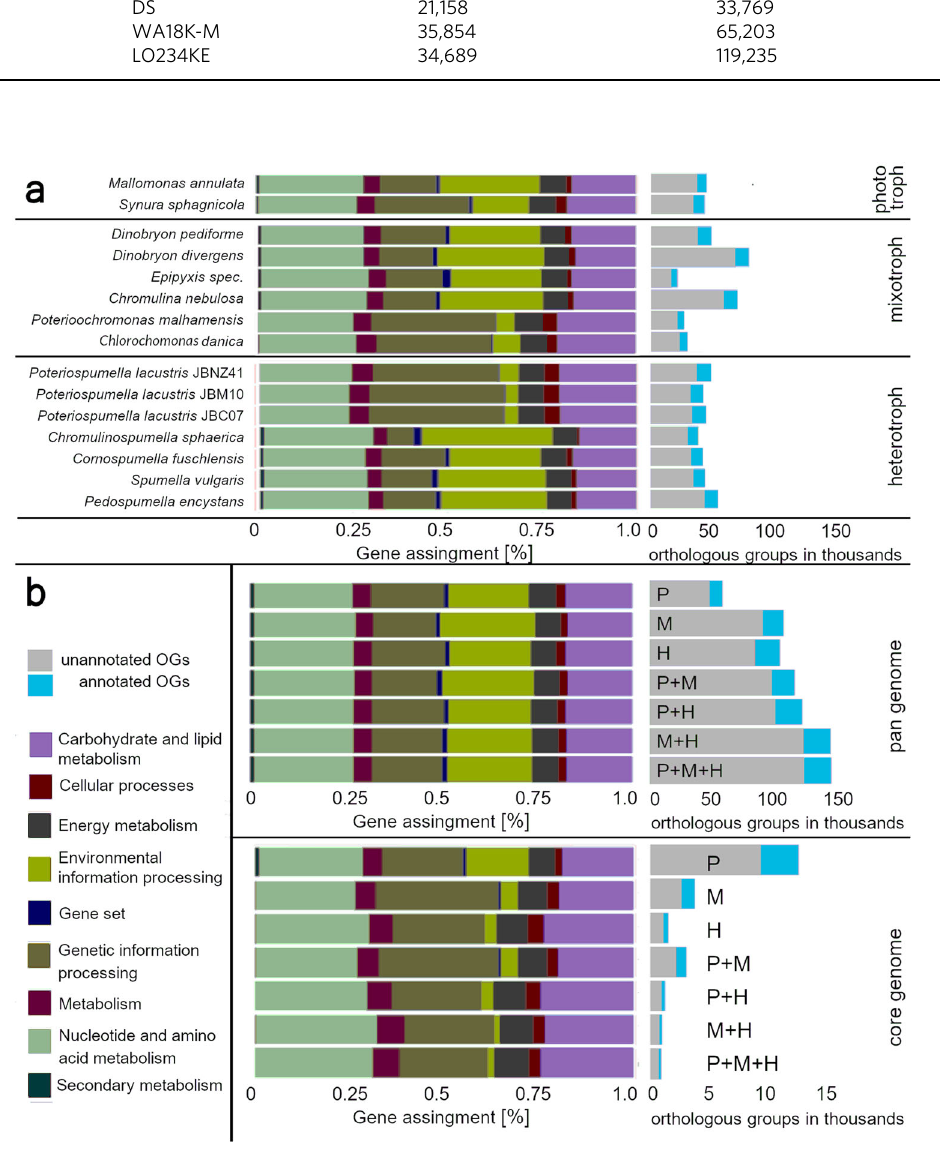
Fig. 1 Scope and gene composition of speci fi c groups. Genes were clustered to orthologous groups (OGs), whose composition is based on gene assignment with the KEGG top hierarchy level. The total amount of OGs is shown by gray (unannotated) and light blue (annotated) bars. a Single strains. b Combination of phototrophic (P), mixotrophic (M), and heterotrophic (H) strains. The pan genome contains every gene of the speci fi c combination, whereas the core genome consists only of genes present in each strain of the group. See supp. Table S6 for